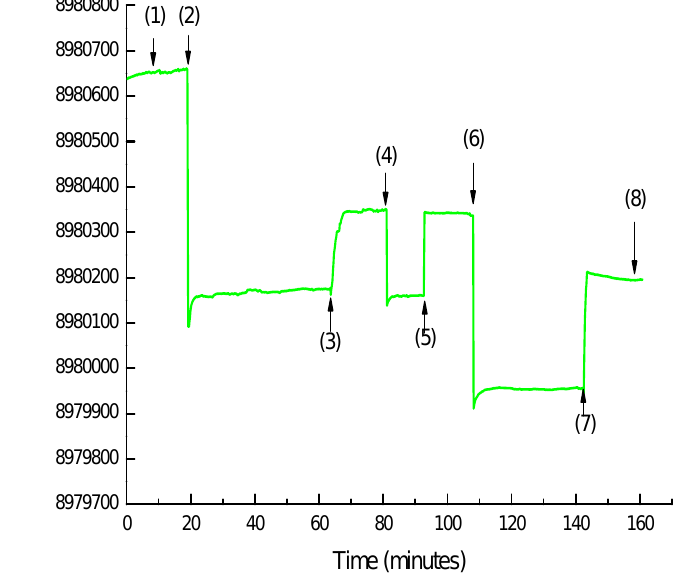
Figure 3. QCM sensorgram by the immobilization amount of ET-1 (2)–(4) and the adsorption amount of P. radix 801 (6)–(8) (pH 7.4 PBST, 1.8 mg mL -1 ET-1, 10 mg mL -1 P. radix